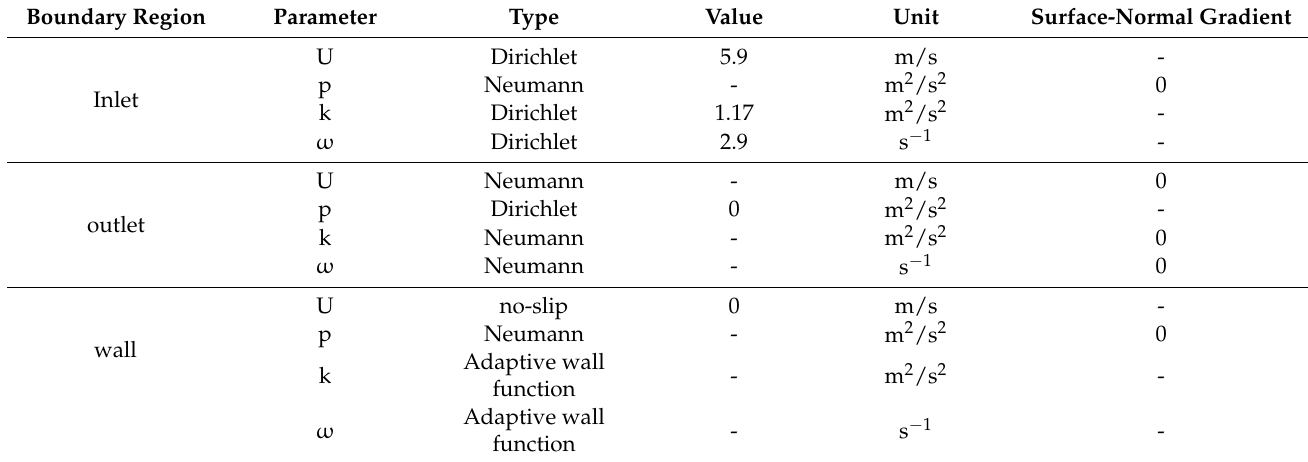
Table 1. Boundary conditions of simulations based on the k- ω SST model.